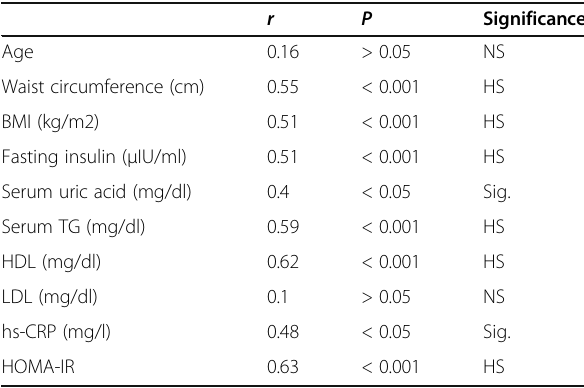
Table 2 Correlation using post hoc test r P Significance